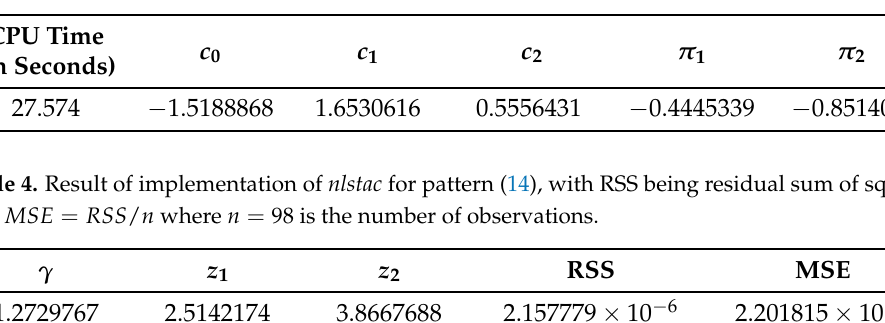
Table 3. Result of implementation of nlstac for pattern (14).